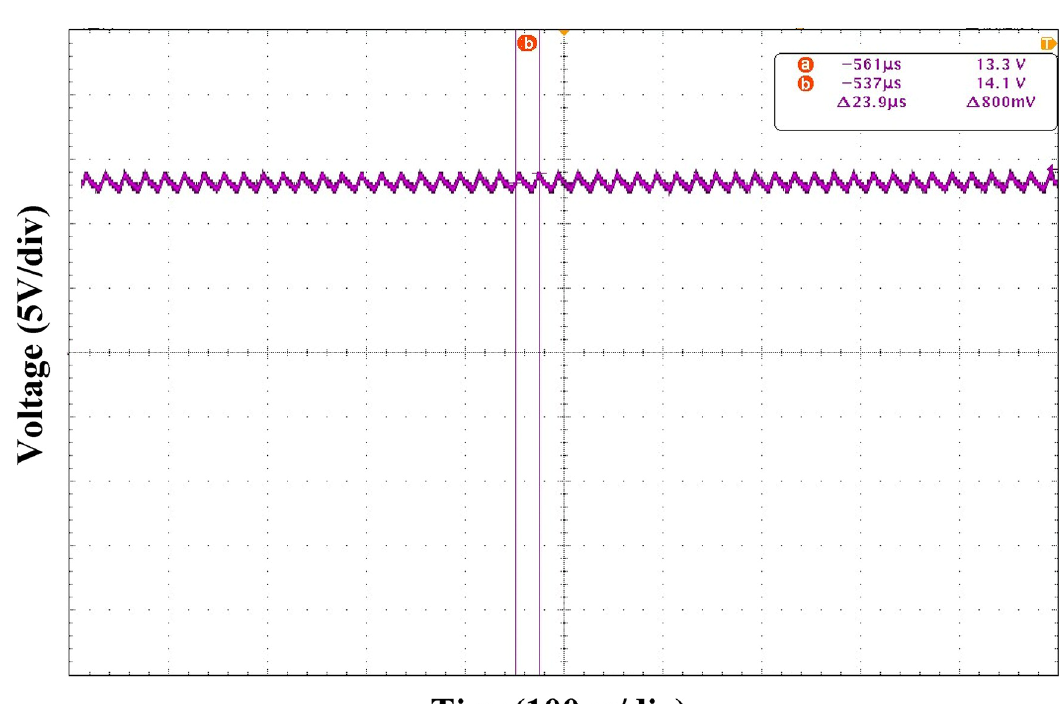
Fig 25. Output voltage waveform under PI control strategy.